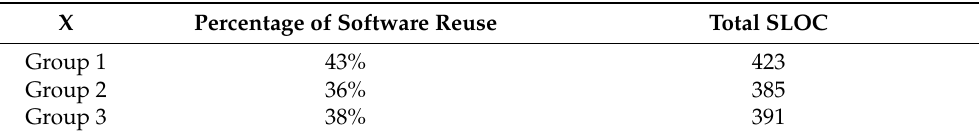
Table 3. Records of the percentage of software reuse in the execution of the IRArduino-SPL case study. X